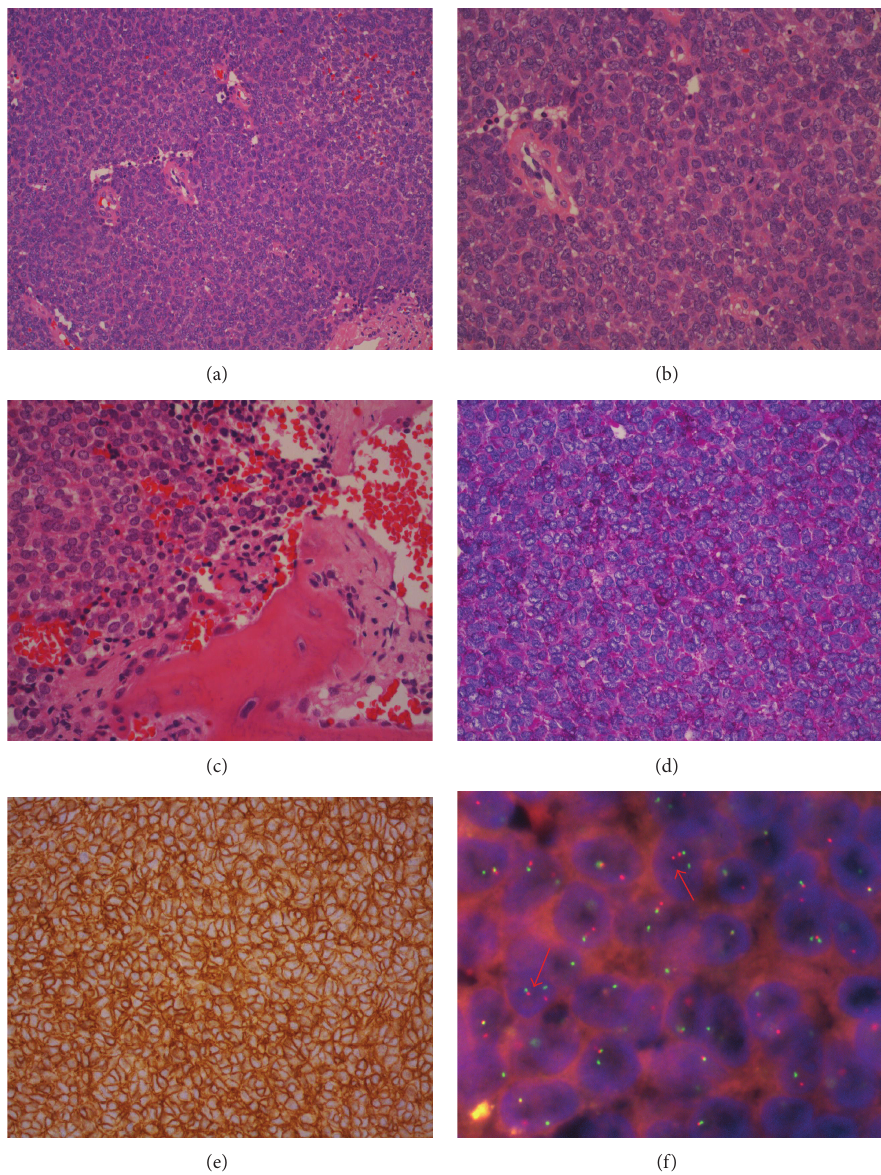
Figure 2: (a) Diffuse sheets of tumor cells. H&E, × 20. (b, c) Tumor cells with scanty cytoplasm and round to ovoid nuclei infiltrating the bone. H&E, × 40. (d) High amount of glycogen in the tumor cells by granular PAS positivity. PAS, × 40. (e) Membraneous expression of neuronal marker CD99. ABC, × 40. (f) Split signal of EWRS1 gene located in the tumor cells (arrows). FISH technique, ×